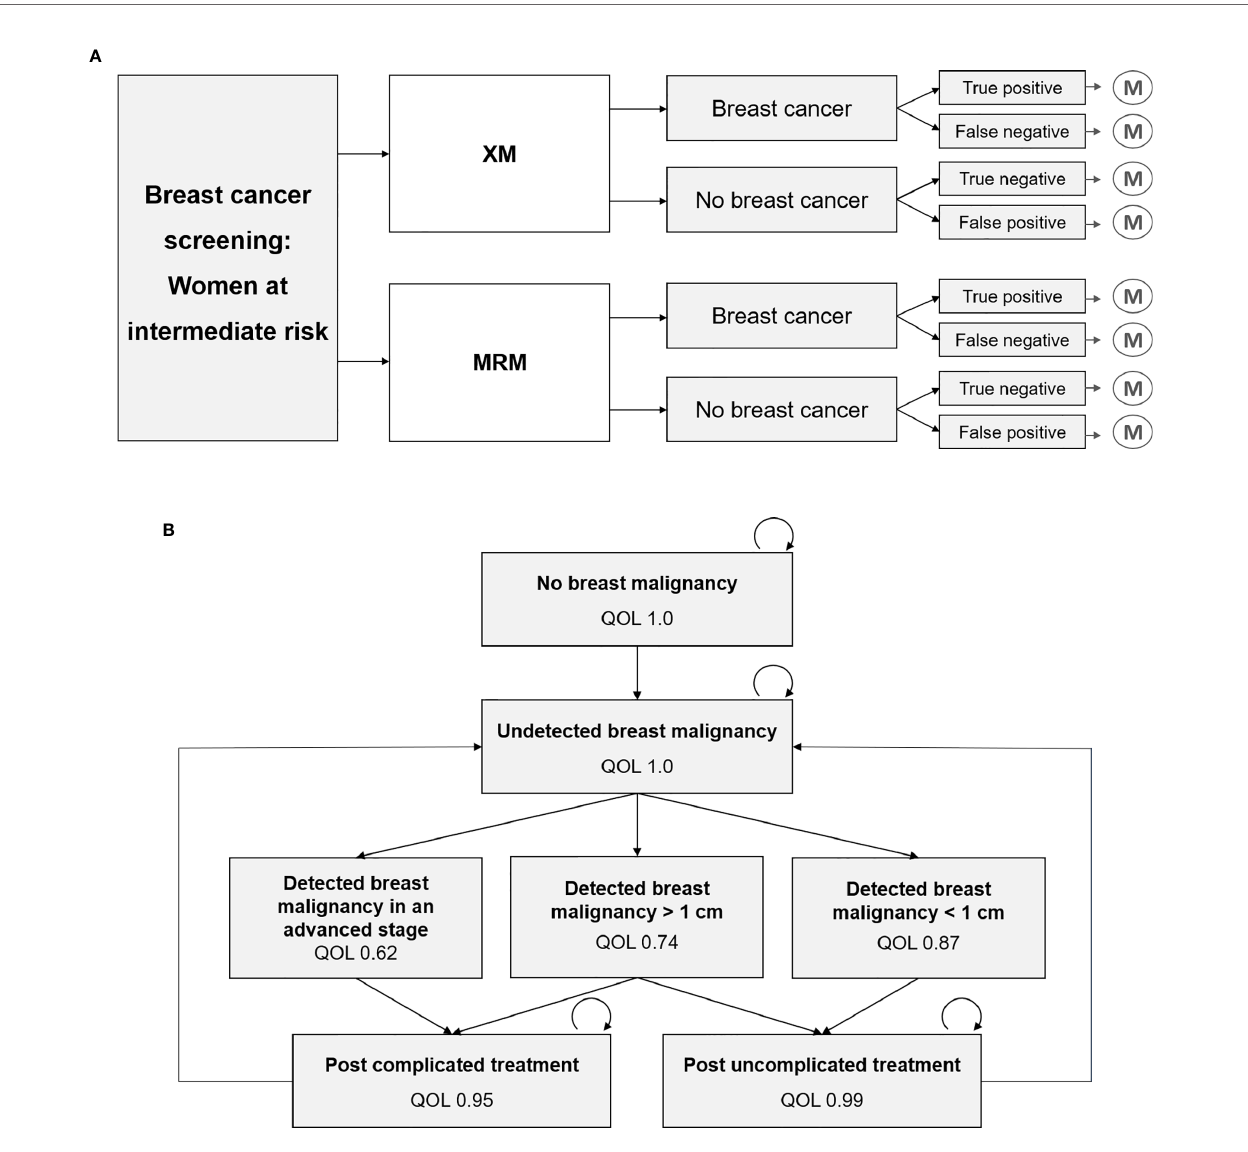
FIGURE 1 | Decision tree and Markov model, which have recently been developed and re fi ned for this study (6, 12, 13). (A) Decision model that represents the diagnostic strategies x-ray based mammography (XM) versus MR-mammography (MRM), and the respective outcomes true positive, false negative, true negative and false positive, that each result in a Markov model simulation. (B) Markov model with various health states and their associated quality of life (QOL). Transition to death is not